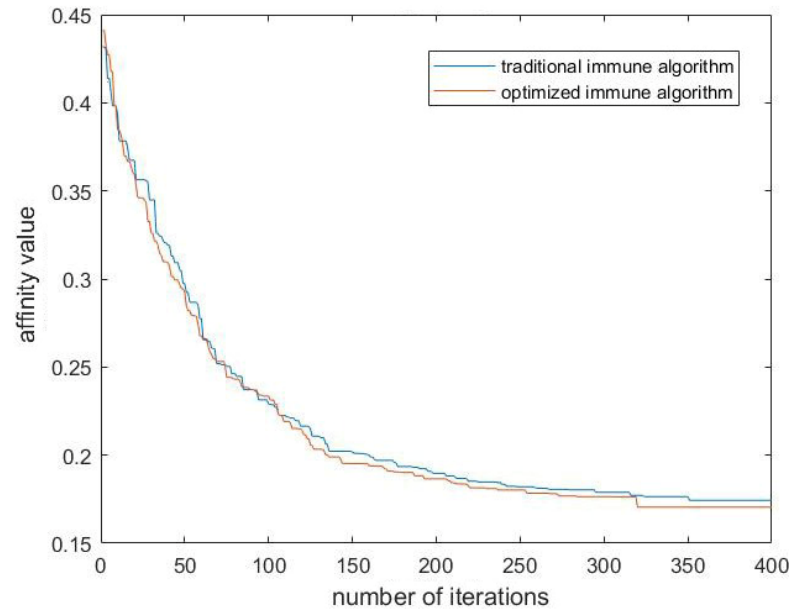
Figure 11. Immune algorithm convergence